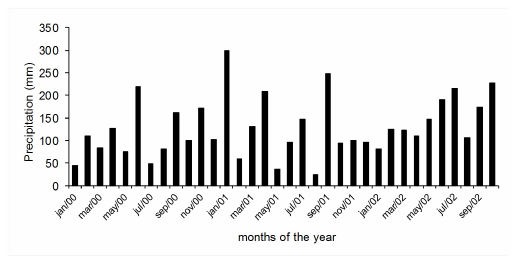
Figure 2. Monthly precipitation variation (mm)